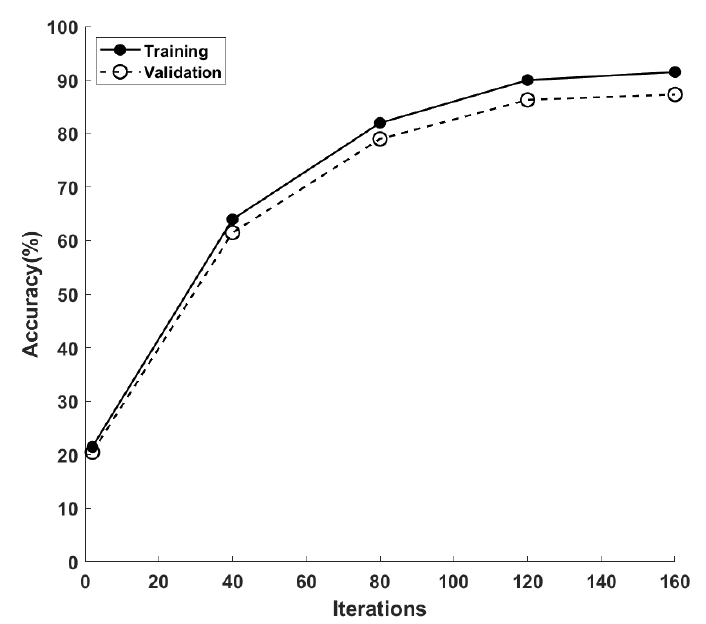
Figure 11. Average Training and Validation Accuracy of the LSTM Scheme through Iterations.